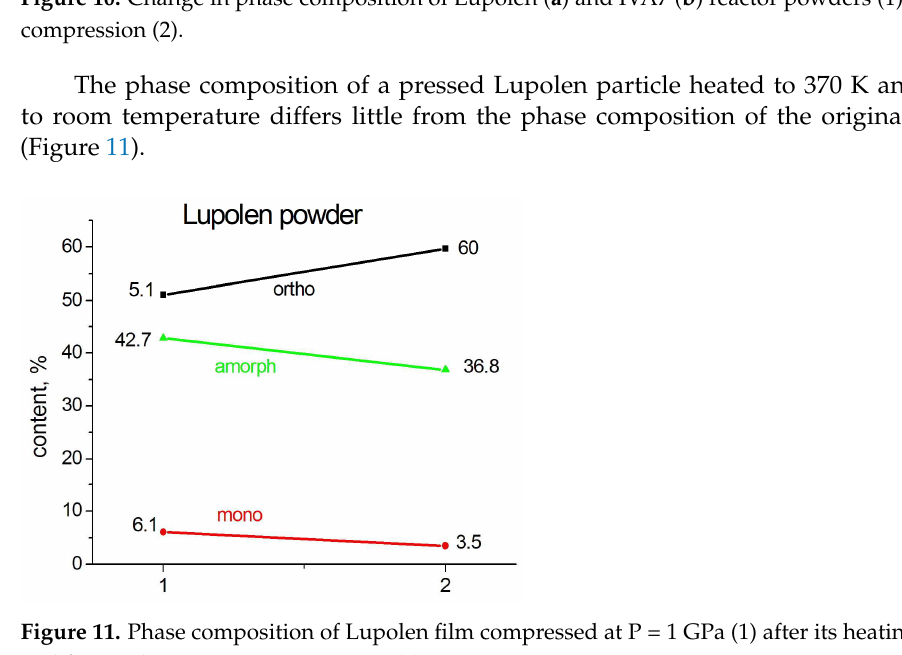
Figure 10. Change in phase composition of Lupolen ( a ) and IVA7 ( b ) reactor powders (1) after cold compression (2).